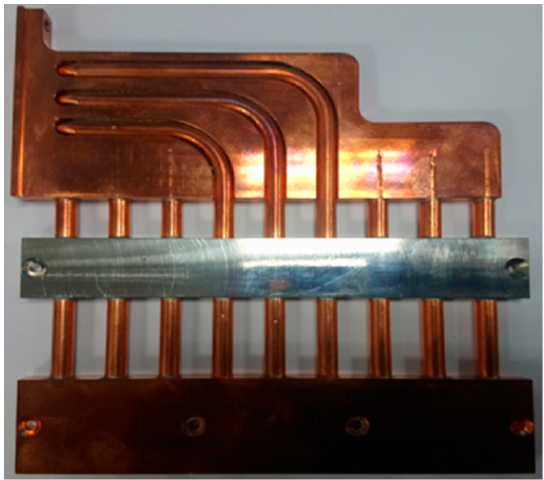
Figure 13. Specimen Type